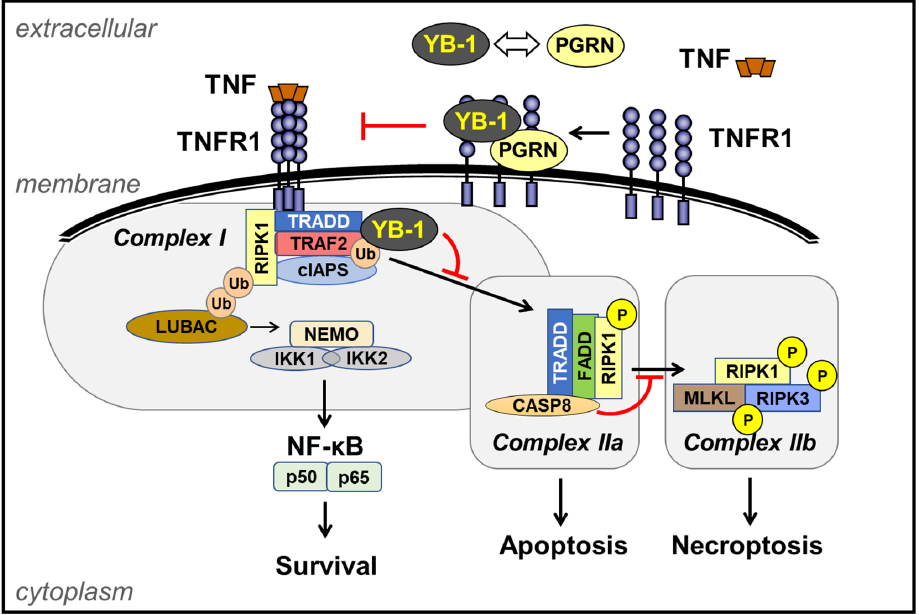
Figure 2. Relationships of different TNFR1 complexes. Upon the binding of TNF to TNFR1, TNFR1- associated death domain (TRADD) is recruited, which then binds to receptor-interacting protein kinase 1 (RIPK1), TNFR-associated factor 2 (TRAF2), and the cellular inhibitor of apoptosis protein 1 and 2 (cIAP1/2) to form complex I [50,51] . cIAP1/2 and the linear ubiquitin chain assembly com-